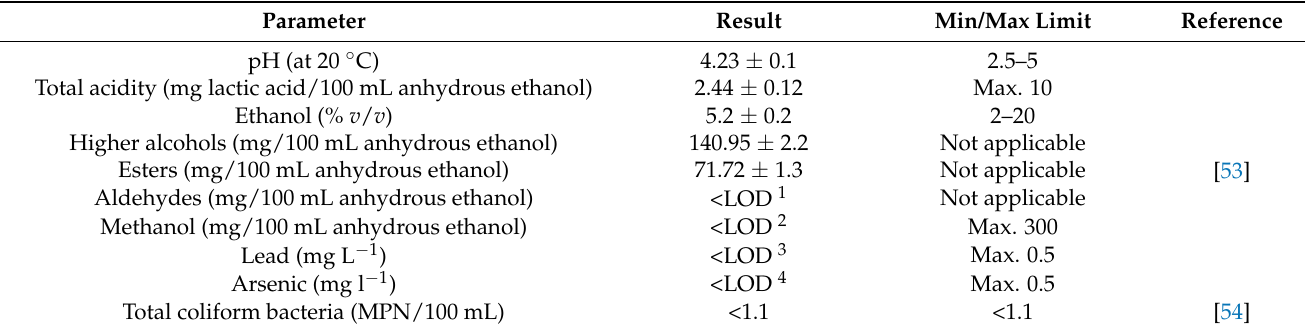
Table 4. Physicochemical and microbiological parameters of the beer made with Pichia kudriavzevii 4A as the starter